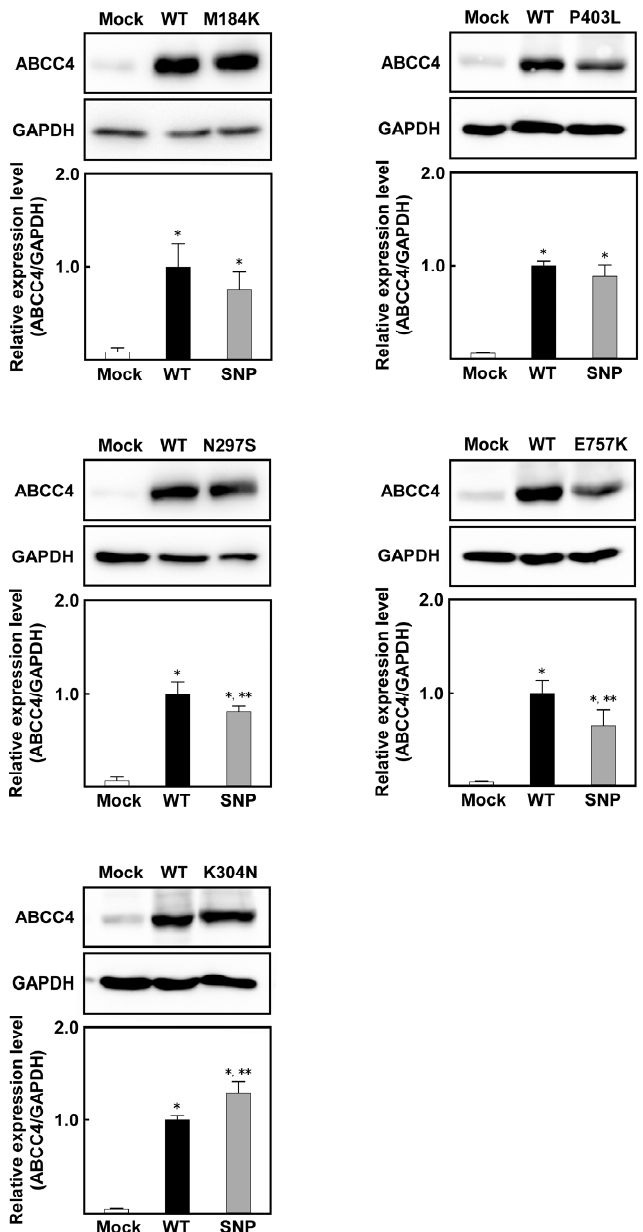
Figure 3. Levels of ABCC4 in cells established using the Flp-In™ system. ABCC4 and GAPDH levels were detected using western blot analysis with specific antibodies for ABCC4 and GAPDH, and their levels were measured using ImageJ (Wayne Rasband, Bethesda, MD, USA) as described in Materials and Methods. ABCC4-specific monoclonal antibody (M4I-10) or GAPDH-specific antibody was used for protein detection in PNGase F-treated cell lysate. The experiments were performed independently more than two times. Data are expressed as mean values ± S.D. ( n = 3 or 4). Statistical analyses for significance were performed using one-way ANOVA and Tukey HSD test (* p < 0.05 compared to the Mock group; ** p < 0.05 compared to the WT).